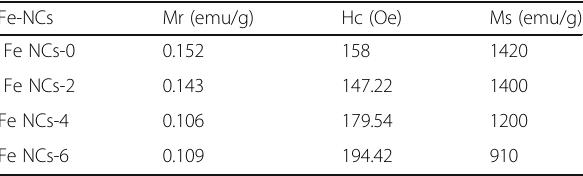
Table 4 Measured values of saturation magnetization (Ms), Coercivity (Hc), and Remanent magnetization (Mr) from the Hysteresis loop of Fig.